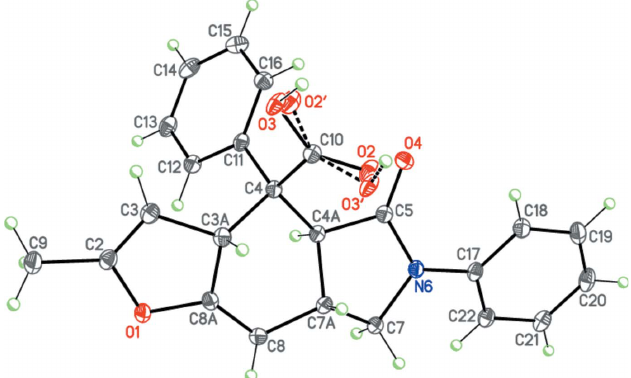
Figure 4 Molecular structure of II . Displacement ellipsoids are shown at the 50% probability level. H atoms are presented as small spheres of arbitrary radius. The minor occupancy position of the –COOH group is depicted with dashed lines.